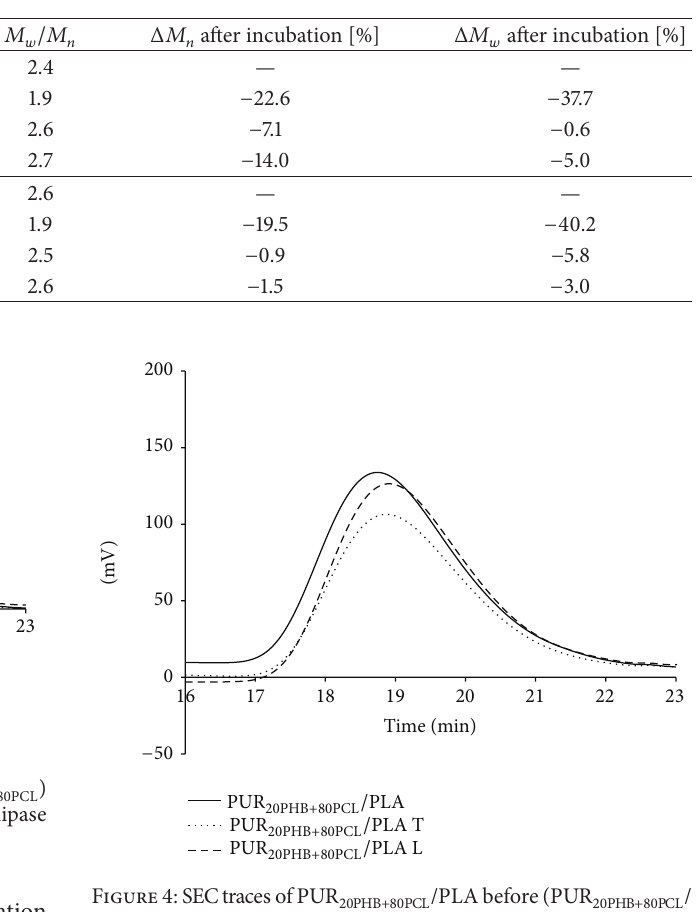
Table 6: Molecular weights of polyurethane (PUR (L), and trypsin (T).